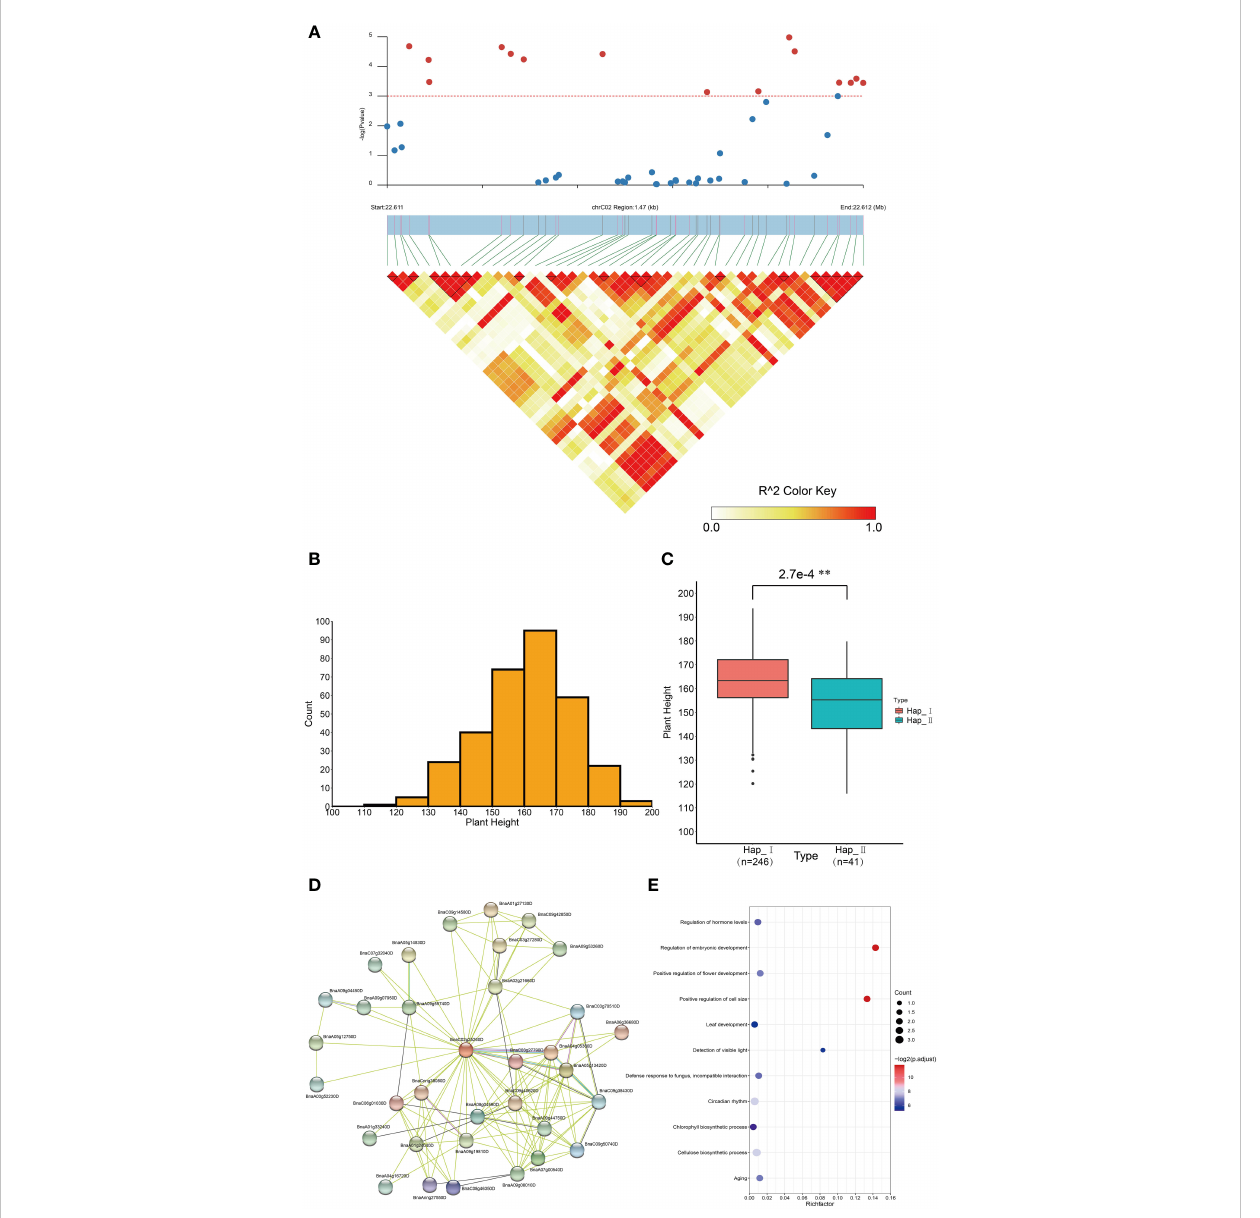
FIGURE 8 Association mapping analysis of BnaC02g25260D in B. napus germplasm with 324 core collections. (A) Signi fi cant association of BnaC02g25260D with tplant height. (B) Distribution of the plant height of 324 accessions. (C) Box plot showed the comparison of plant height between two haplotypes divided based on the most signi fi cantly associated SNP in BnaC04g00810D . (D) Protein-protein interaction network of BnaC02g25260D. (E) GO enrichment analysis of BnaC02g25260D interacting proteins. **p <